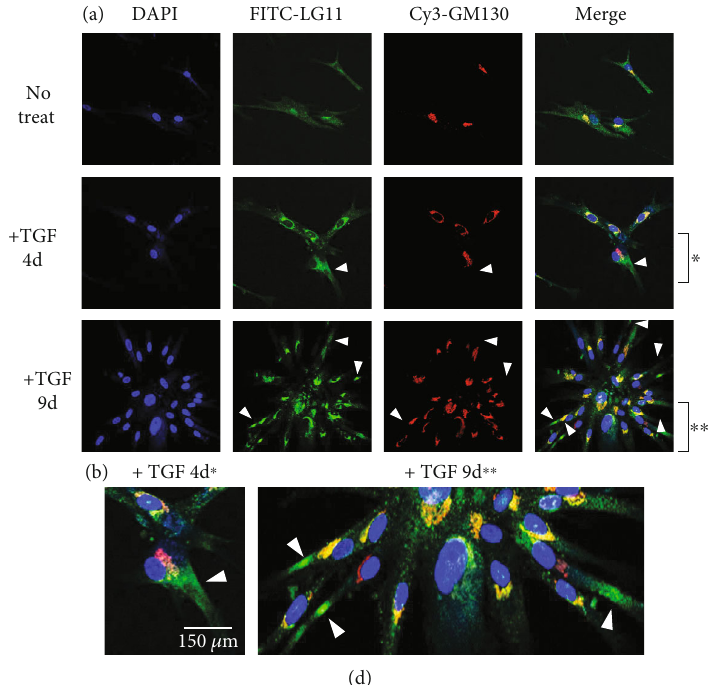
Figure 3: GOLGA5/LG11 is a PDL- fi broblast speci fi c Golgi marker. (a) GOLGA5/LG11 accumulated in PDL region of tooth root. Immunohistochemistry analysis using human (A) and fetal mouse (B) tooth slices. Anti-PLAP-1 antibody was used as the positive marker of periodontal ligament. (b) GOLGA5/LG11 was detected in membrane fraction of TGF- β 1-induced PDL- fi broblastic cells. Total: total cell extract; cyto: cytosolic phase; mem: membrane fraction. (c) Subcellular localization of endogenous GOLGA5/LG11 in undi ff erentiated hPDLSCs. The representative organelle markers, such as GM130, calnexin, integrin β 5, and vinculin, were detected by Cy3 for red colors (Cy3-markers), whereas GOLGA5/LG11 was detected by FITC for green colors. Nuclei were detected by DAPI staining. (d) Subcellular localization of endogenous GOLGA5/LG11 and GM130 during TGF- β 1-induced fi broblastic di ff erentiation. hPDLSCs grown on coverslips were treated with TGF- β 1 for the indicated times (4 and 9 days) and applied for immunocytochemistry. As the di ff erentiation progressed, the more cells in which LG11 and GM130 were separated from each other were detected (arrowheads). Areas marked with asterisks ( ∗ and ∗∗ ) in (A) are enlarged and shown in